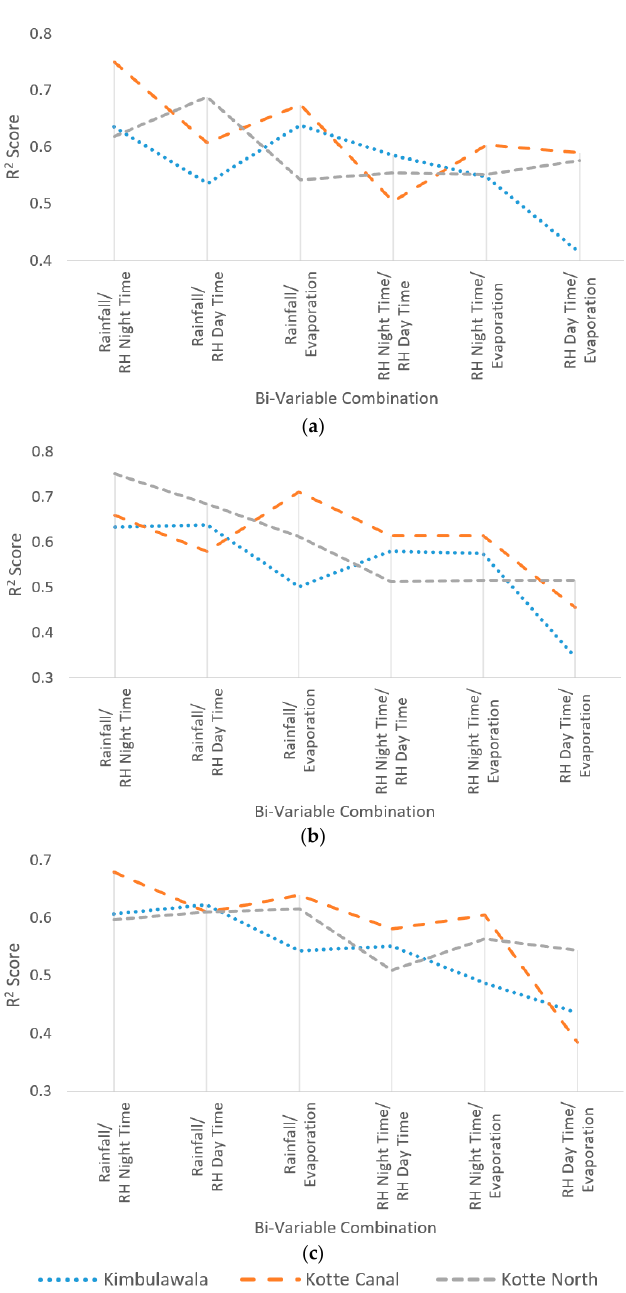
Figure 5. Bi-Variable Sensitivity Analysis (R 2 Score): ( a ) under the Levenberg Marquardt algorithm; ( b ) under the Bayesian Regularization algorithm; ( c ) under the Scaled Conjugate Gradient algorithm.